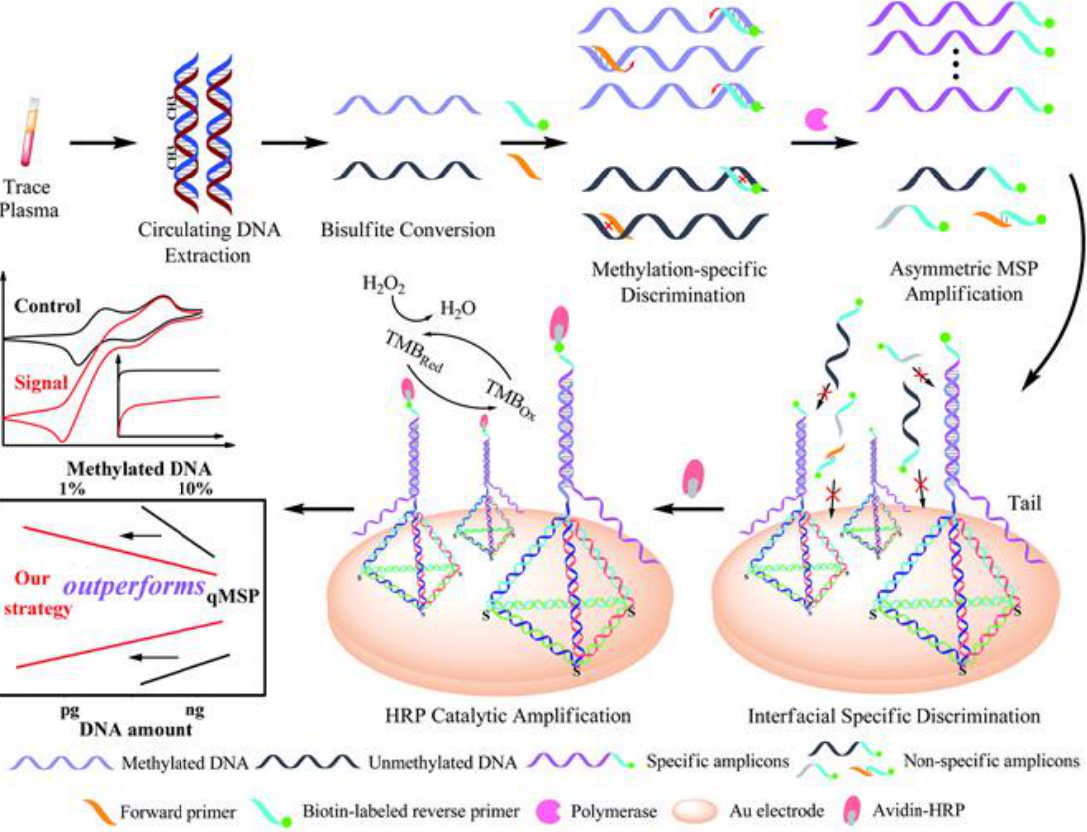
Figure 5. Chronoamperometric determination of circulating methylated DNA at single copy level involving bisulfite treatment, aMSP and efficient hybridization of the specific ss-amplicons on a gold electrode modified with tetrahedral DNA nanostructures. Reprinted from [28] with permission.